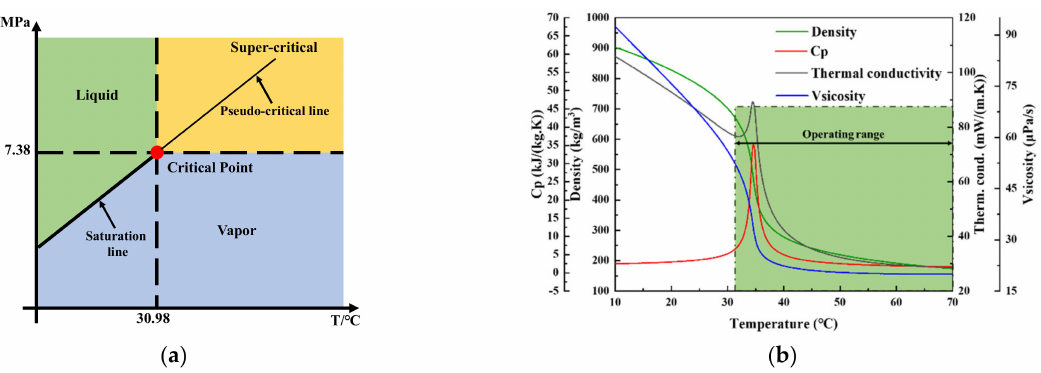
Figure 1. CO 2 p–T diagram ( a ) and variation in thermo–physical properties for SCO 2 in 8 MPa ( b